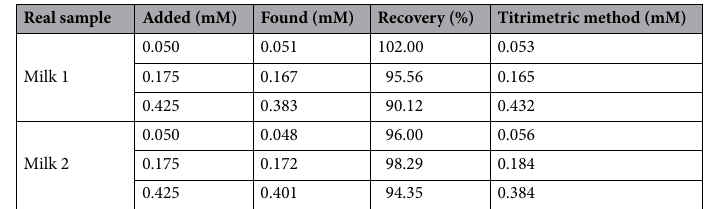
Real sample Added (mM) Found (mM) Recovery (%) Titrimetric method